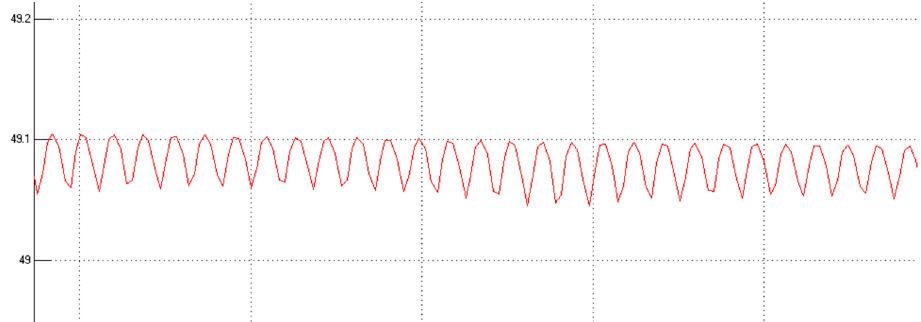
Figure 15. Stability of motor speed under sliding mode control.